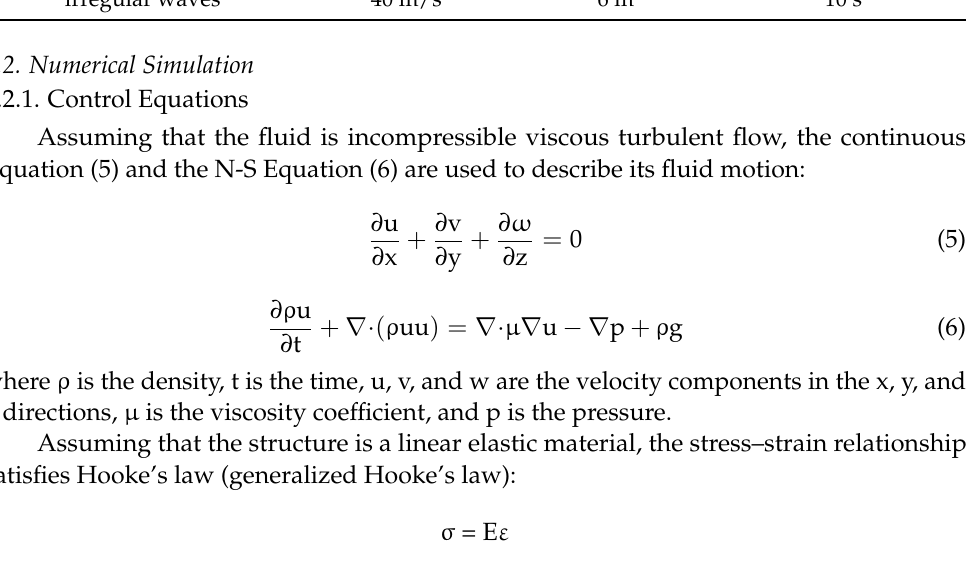
Table 1. Random wind and wave parameters. Conditions Wind Speed Wind Height Wind Period Operating sea conditions Rule Waves irregular